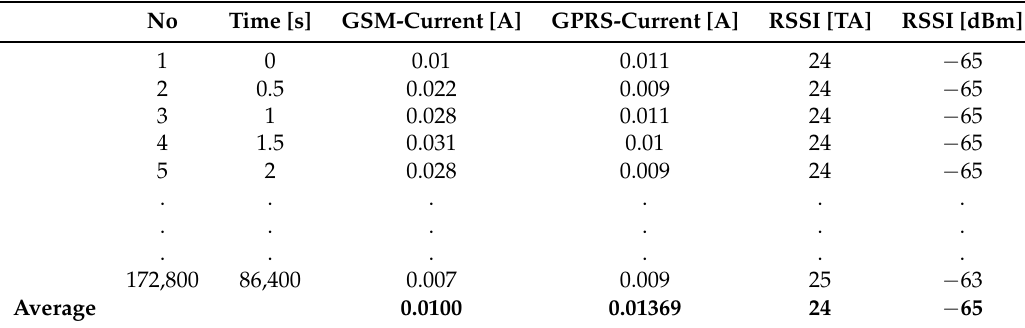
Table 8. Current consumption in location 5, RSSI = − 65 dBm.